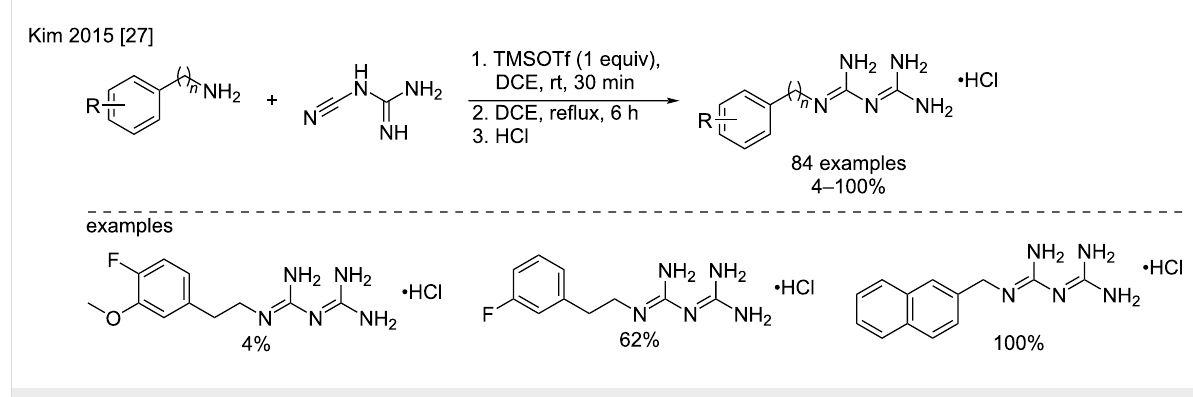
Scheme 9: Synthesis of phenformin analogs by TMSOTf activation